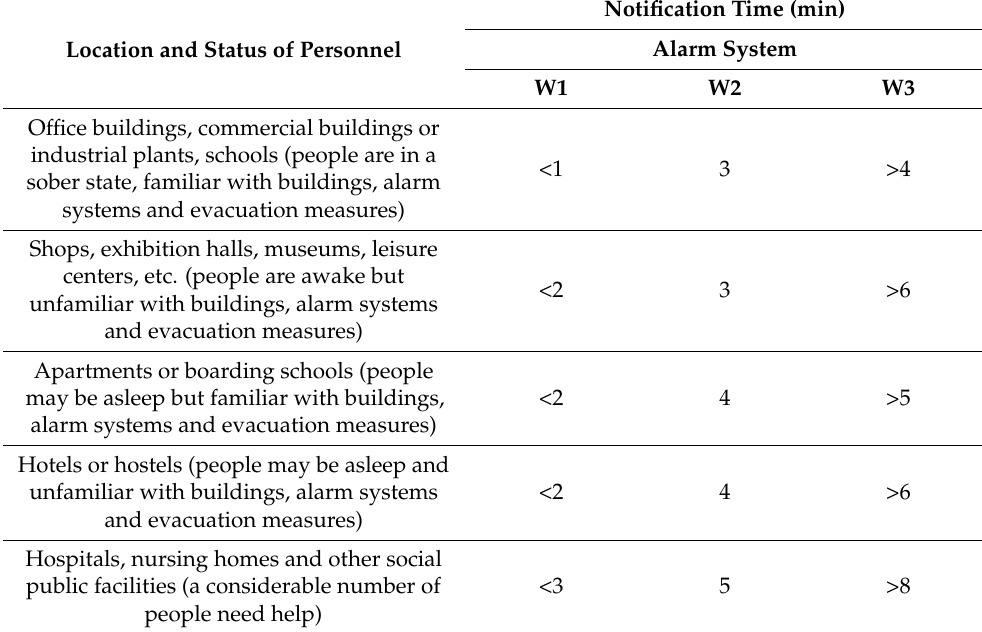
Table 2. Statistical results of notification time when different alarm systems are used in buildings for various